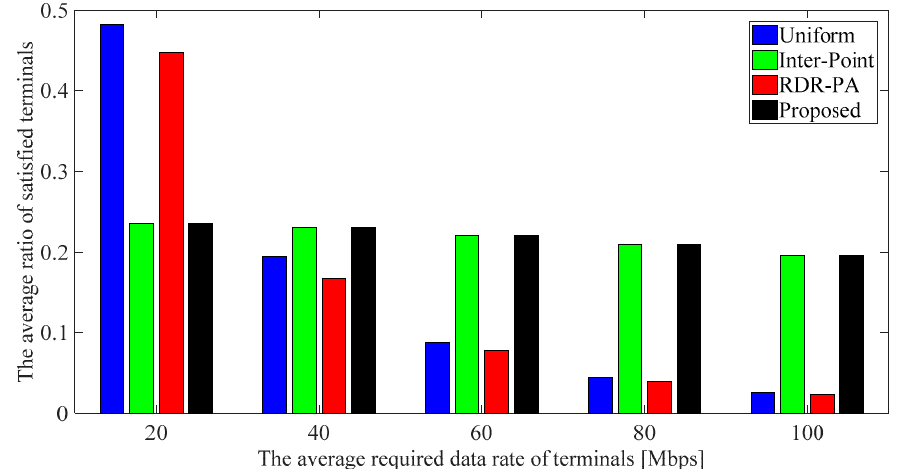
Figure 8. The average ratio of satisfied terminals versus the average required data rate of terminals.